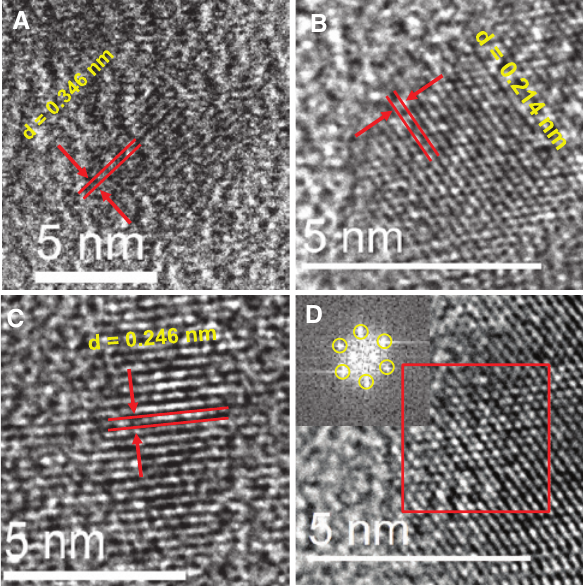
Figure 3: (A–C) HRTEM images of NGQDs, in which three lattice fringes of 0.346, 0.214, and 0.246 nm are observed. (D) FFT image (inset) of a selected area (red square), in which the hexagonal crystal structure is revealed with a lattice parameter of 0.214